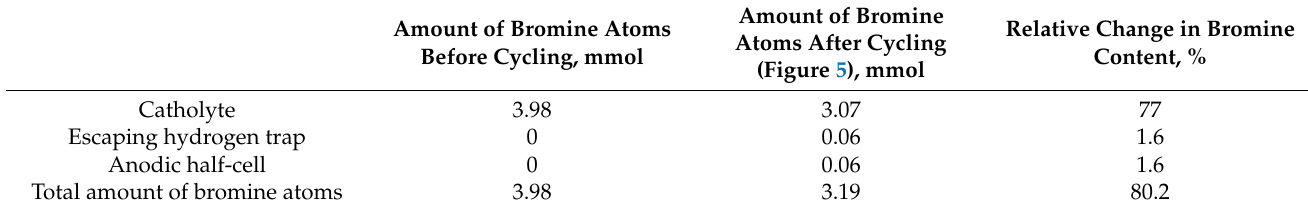
Table 2. Estimation of losses of Br-containing compounds after charge-discharge